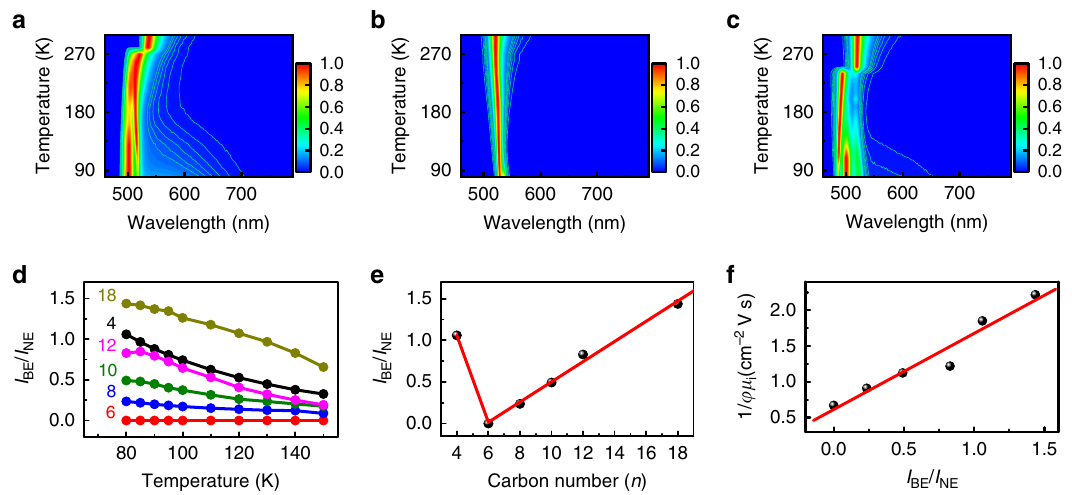
Fig. 2 Temperature-dependent fl uorescence map of 2D OIHP fi lms obtained by heating from 80 K to room temperature. a BA 2 PbI 4 ( n = 4), b HA 2 PbI 4 ( n = 6), and c OA 2 PbI 4 ( n = 8). d Ratio of integrated BE to NE PL intensity (I BE /I NE ) of six samples as a function of temperature range from 80 K to 150 K. e The I BE /I NE ratio at 80 K is plotted against the alkyl chain length of organic cations. f The correlation between the I BE /I NE ratio at 80 K and the reciprocal of the in-plane